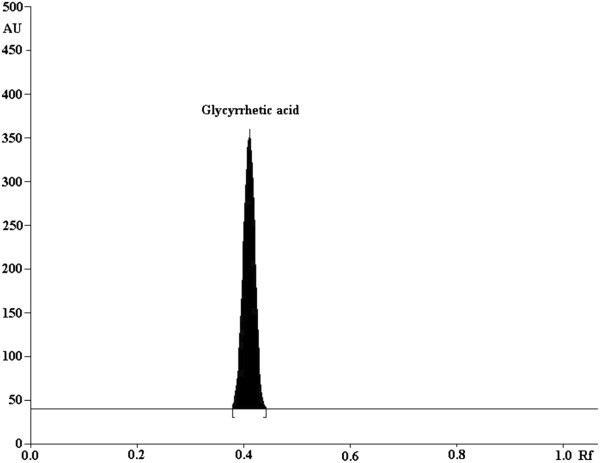
HPTLC Chromatogram of standard glycyrrhetic acid (1000 ng spot-1): peak 1 (Rf = 0.42 ± 0.03), mobile phase; chloroform: methanol: formic acid (9:0.9:0.1).